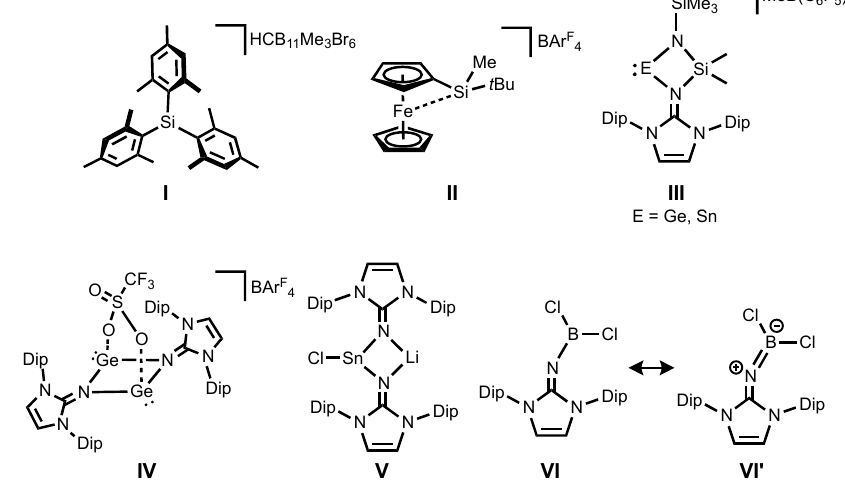
Figure 1. Selected group silylium ions I and II and metallyliumylidenes III and IV as well as bis(imino)stannylenoid V . Dichloroiminoborane VI and its canonical structure VI’ . Dip = 2,6-diisopropylphenyl. Ar F = 3,5-bis(trifluoromethyl)phenyl. It is noteworthy that the syntheses of phosphinoimido complexes of silylium ions were described by Stephan and co-workers and they exist as a dimer VII or a phosphinoimido-coordinated monomer VIII depending on the steric crowding of the substituents ( t Bu vs. i Pr and Ph) (Scheme 1) [36].